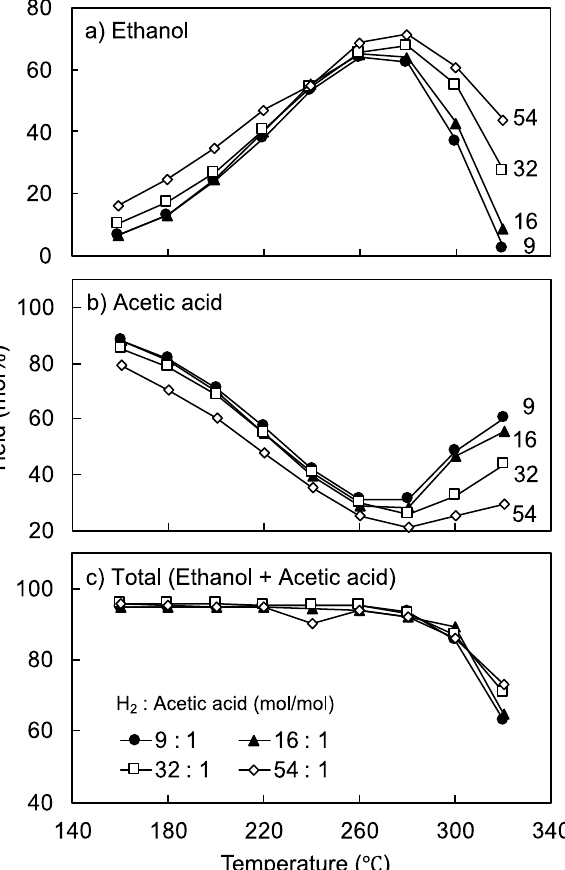
Figure 3. Effect of H 2 /acetic acid ratio on hydrogenation of aqueous acetic acid (10 g/L) to ethanol: ( a ) ethanol; ( b ) acetic acid; ( c ) total (ethanol + acetic acid) (column size, 3.9-mm inner diameter, 100-mm length; pump flow rate, 0.3 mL/min, H 2 flow rate, 10–60 mL/min; pressure, 10 MPa).